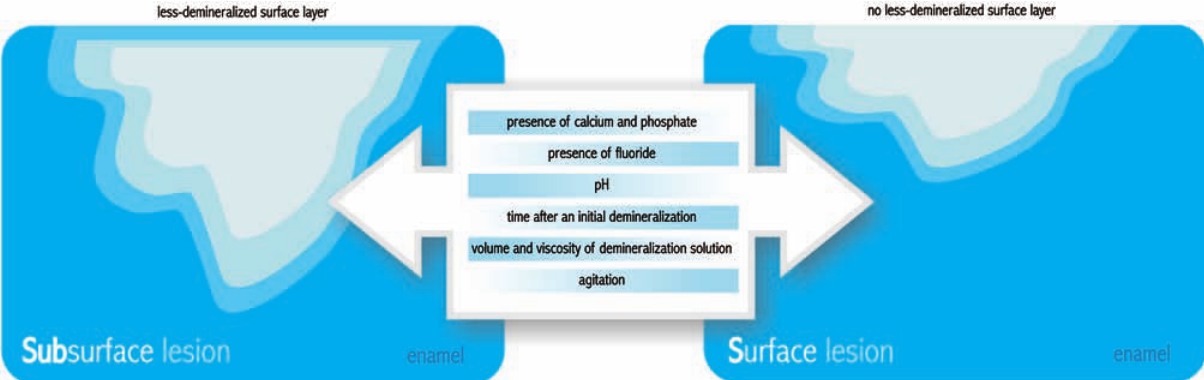
Figure 7- Factors that affect the formation of subsurface lesions (caries-like) and surface-softened lesions (erosion-like)